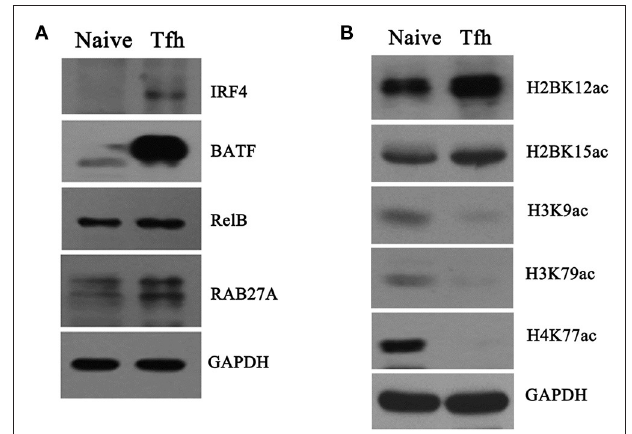
FIGURE 8 | Verification of proteome and acetylome data. Naive CD4 + T cells were purified and induced to differentiate into Tfh cells. Naive CD4 + T cells and iTfh cells on day 5 were harvested, and total protein and the core histone were, respectively, extracted. (A) Four proteins, namely IRF4, BATF, RelB, and RAB27A, were detected by Western blot; (B) The acetylation of five K residues, namely H2BK12ac, H2BK15ac, H3K9ac, H3K79ac, and H4K77ac, was detected by Western blot. GAPDH was used as an inter control for protein quantification in this experiment.